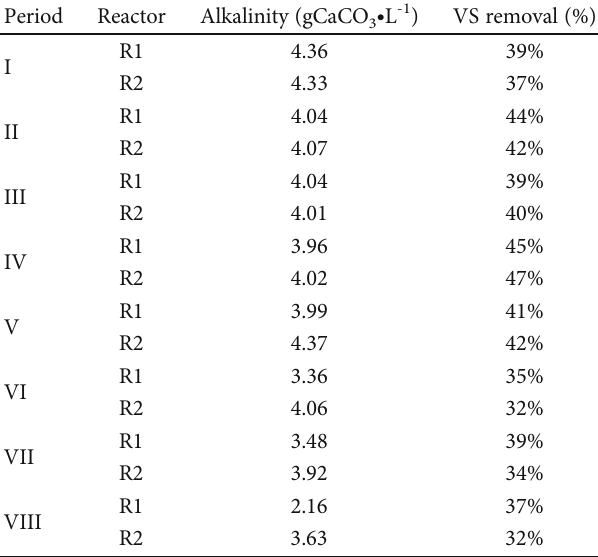
Figure 2: Mean values of parameters measured during each of the eight experimental periods (in brackets the H methane rate (circles indicate outliers); (b) biogas composition; (c) TVFA composition and alcohols; (d) box plots of alkalinity concentrations (circles indicate outliers). Table 4: Summary of reactor alkalinity and VS removal during the experimental